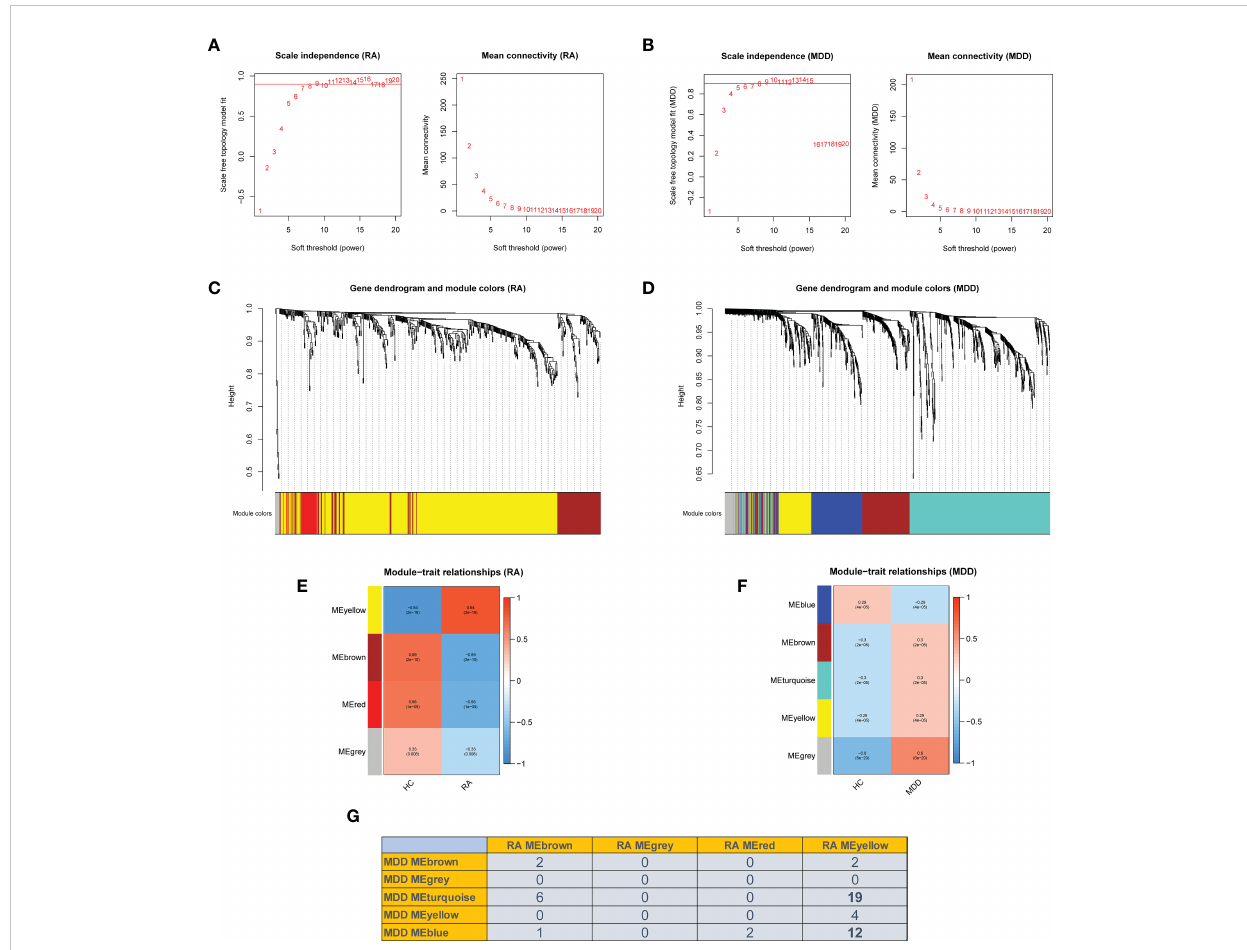
FIGURE 3 Weighted co-expression network related dataset construction and identi fi cation of related key modules in RA and MDD. (A, B) Analysis of network topology for various soft thresholds ( b ). The left panel shows the scale-free fi t index (scale independence, y-axis) as a function of the soft threshold power (x-axis); the right panel displays the mean connectivity (degree, y-axis) as a function of the soft threshold power (x-axis). (C, D) Gene dendrograms were obtained by average linkage hierarchical clustering. The colored row underneath the dendrogram shows the module assignment determined by the dynamic tree cut method. (E, F) Module-trait relationships. Each row in the heatmap corresponds to an ME and each column to a clinical trait. Each cell contains the corresponding correlation and p -value. (G) Number of intersecting genes in related key modules in RA and